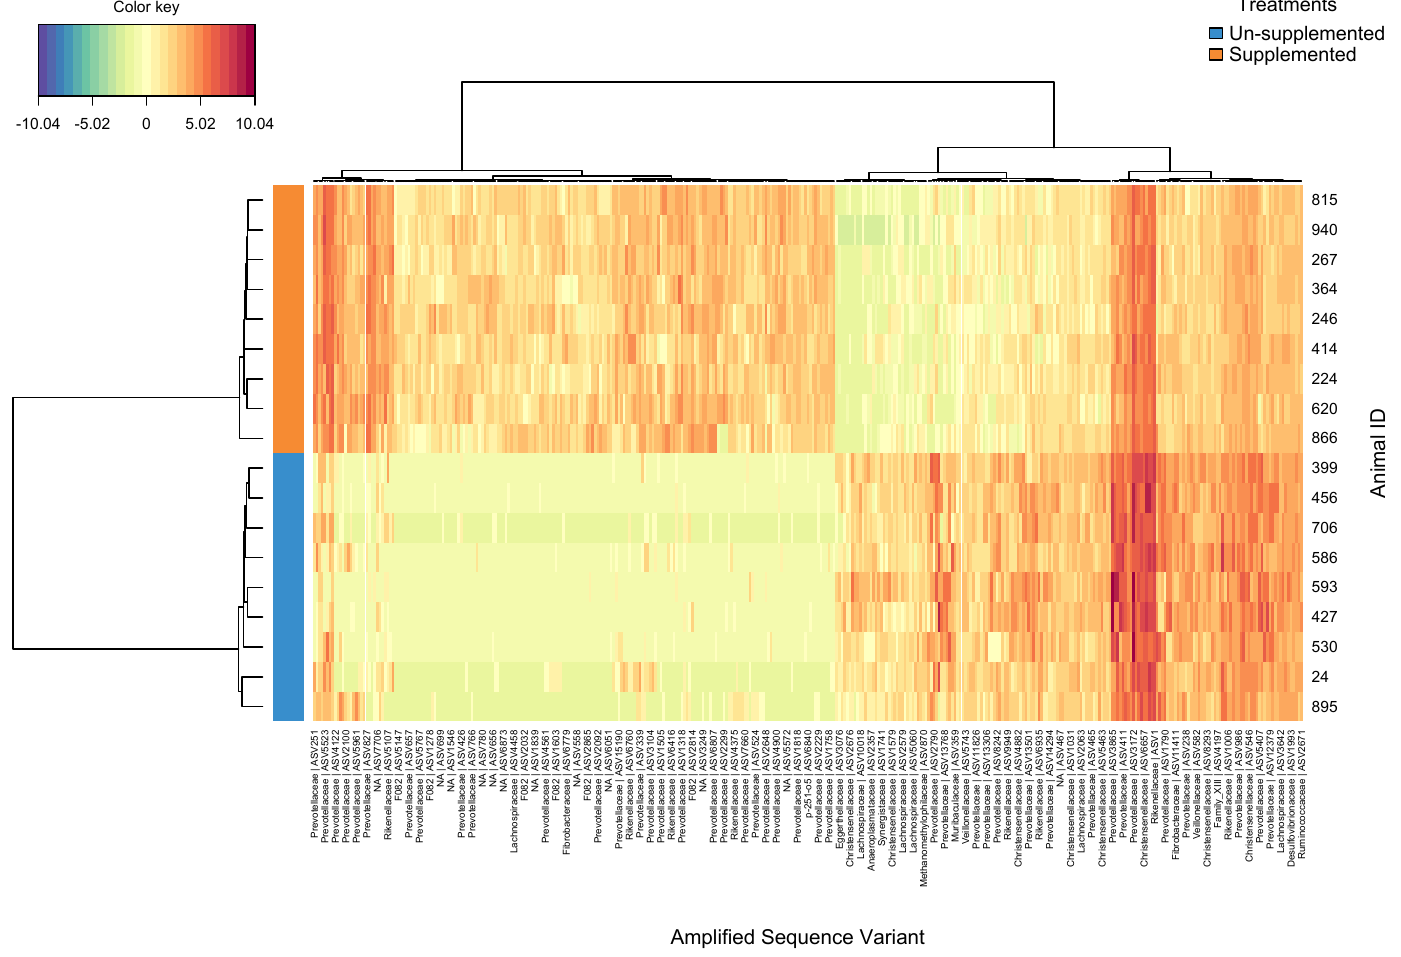
Figure 1. Clustering analysis using a heatmap based on the bacterial ASVs significantly di ff erent from un-supplemented and supplemented animals during the late-dry